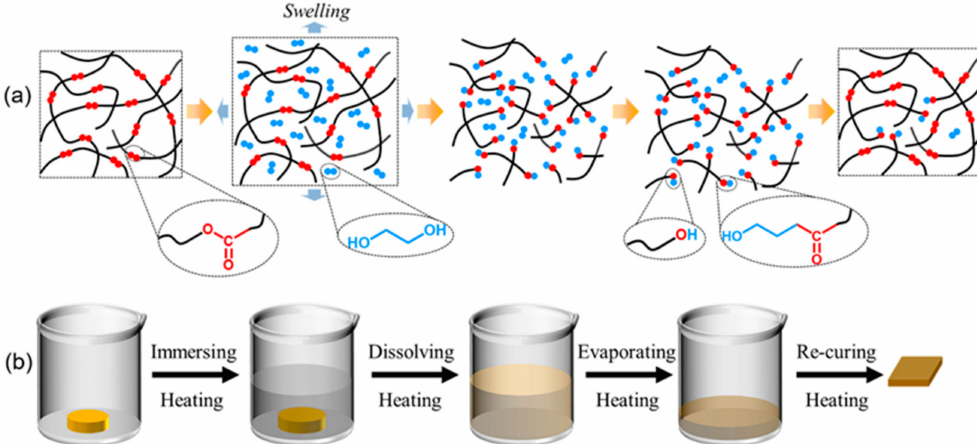
Figure 1. ( a ) The schematic of ethylene glycol (EG)-assisted dissolution and recycling mechanism: The crosslinked network is immersed in EG and heated, then alcohol molecules diffuse into the network and cleave ester bonds on the polymer skeleton. The repolymerization of decomposed epoxy oligomer occurs via evaporating excess EG. ( b ) The schematic illustration of the dissolution and recycling